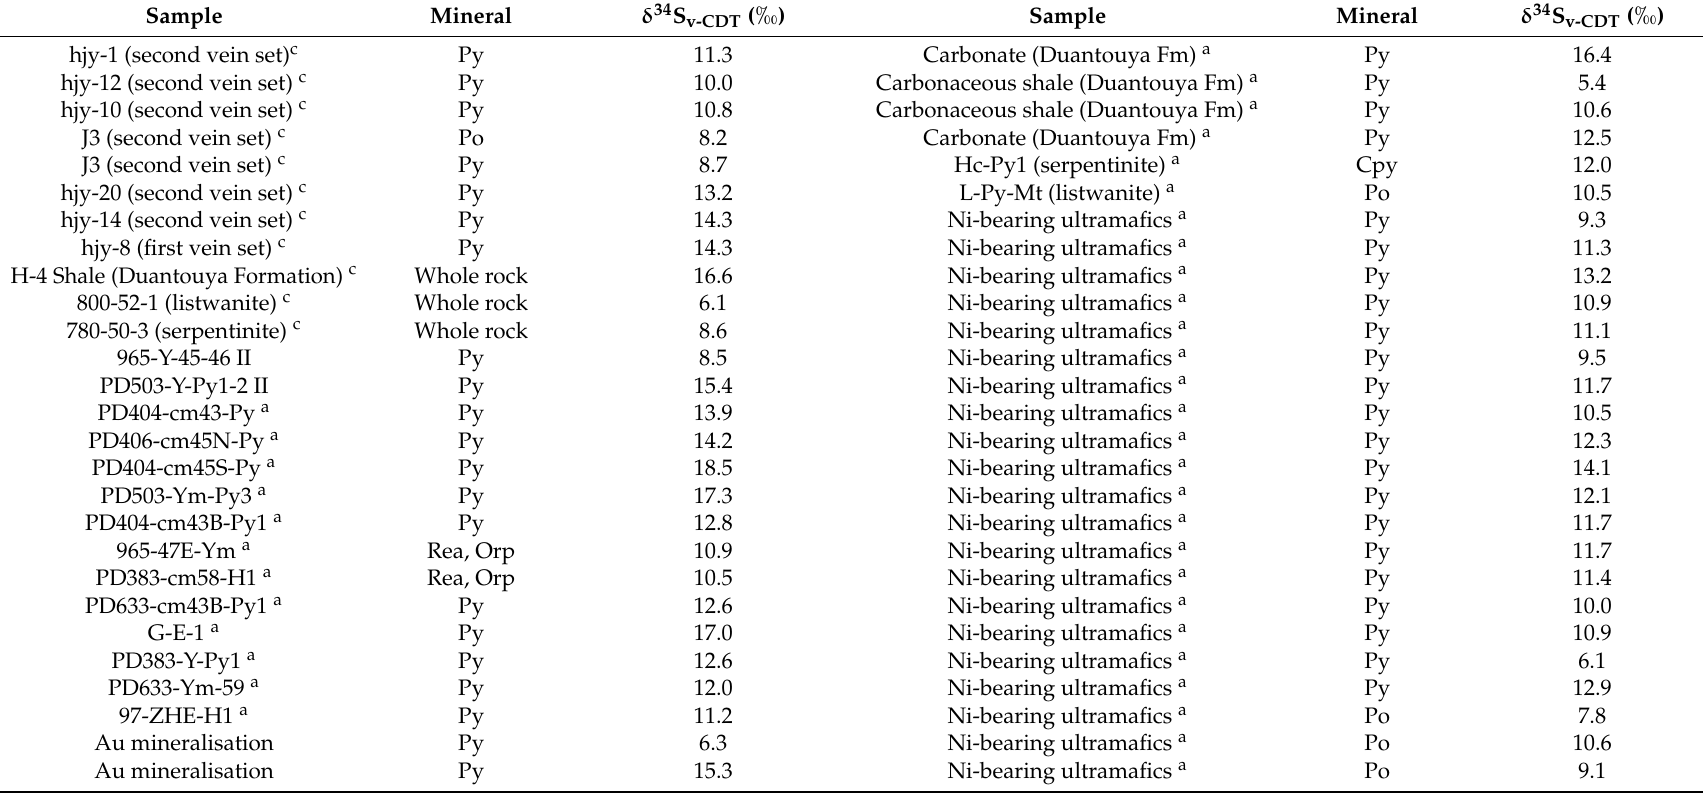
Table 3. Sulfur isotope composition of sulfides and whole rocks in the Jianchaling area (modified from